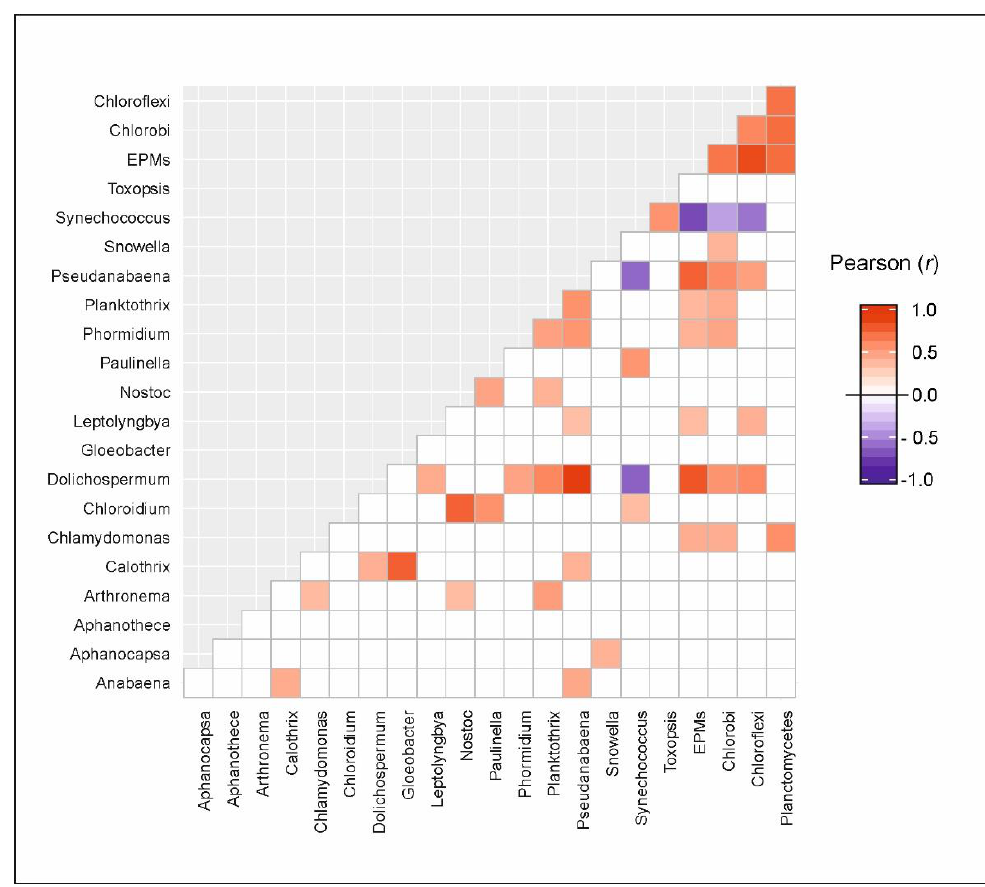
Figure 8. Correlation analysis of associations between relative abundances of cyanobacteria and EPMs during summer HAB in Imandra Lake.